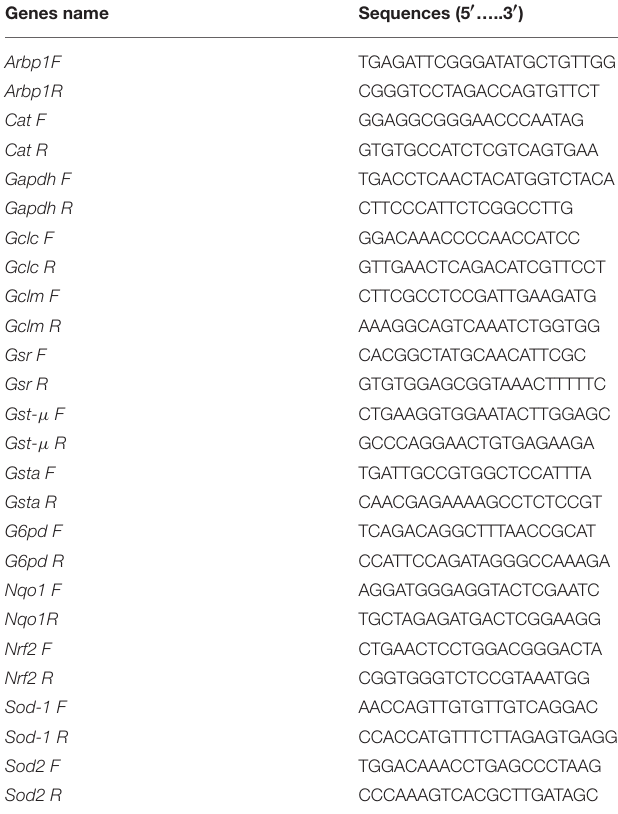
TABLE 1 | List of primers used for the